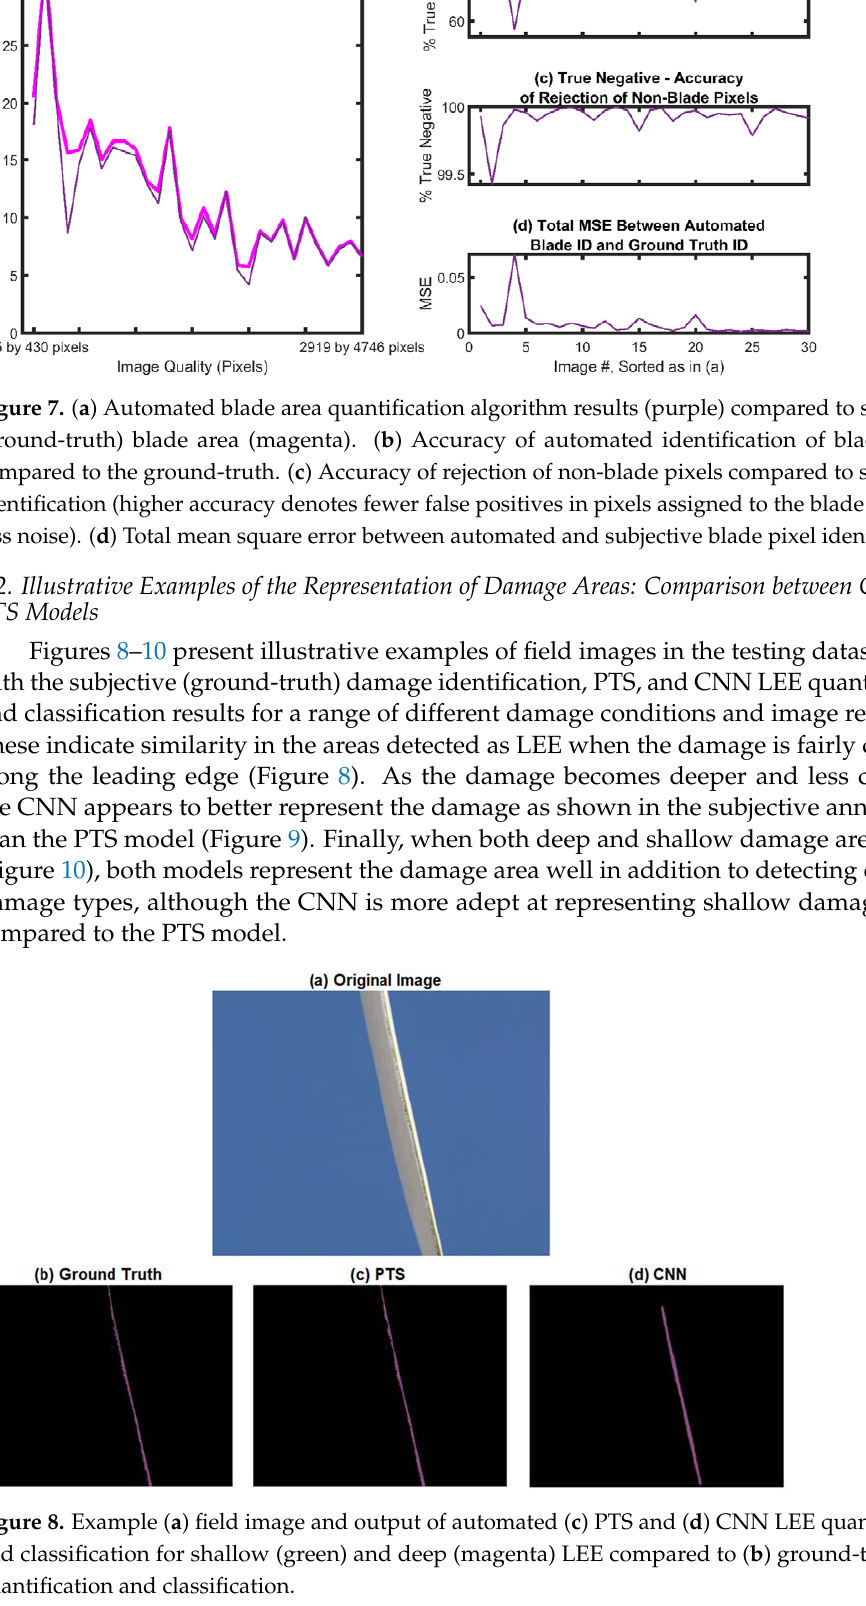
Figure 9. Example ( a ) fi eld image and output of automated ( c ) PTS and ( d ) CNN LEE quanti fi cation and classi fi cation for shallow (green) and deep (magenta) LEE compared to ( b ) ground-truth LEE quanti fi cation and classi fi cation.